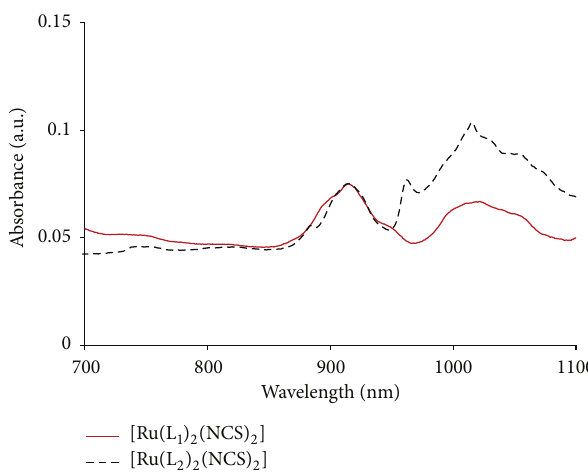
Figure 6: Comparison of the lowest energy absorption bands of [Ru(L 1 ) 2 (NCS) 2 ] and [Ru(L 2 ) 2 (NCS) 2 ] complexes detected in the near infrared region of 900–1022 nm ( 𝜀 = 5.70 − 7.80 × 10 3 M −1 cm −1 ).